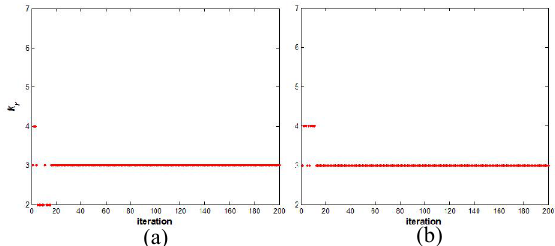
Figure 4. Changes of k r for real SAR image: (a) coastal image, and (b) estuary image.